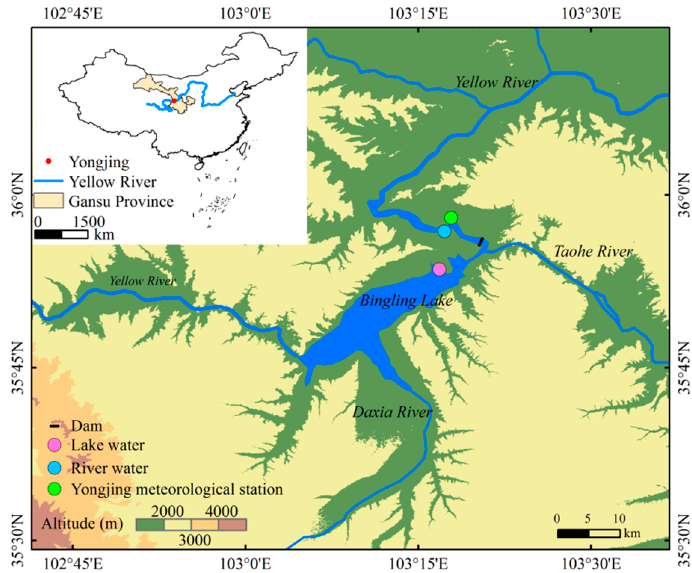
Figure 1. Map showing the sampling sites of lake water and river water in this study. The Yellow River, the Daxia River, and the Taohe River flow into the Bingling Lake and flow out through the dam.